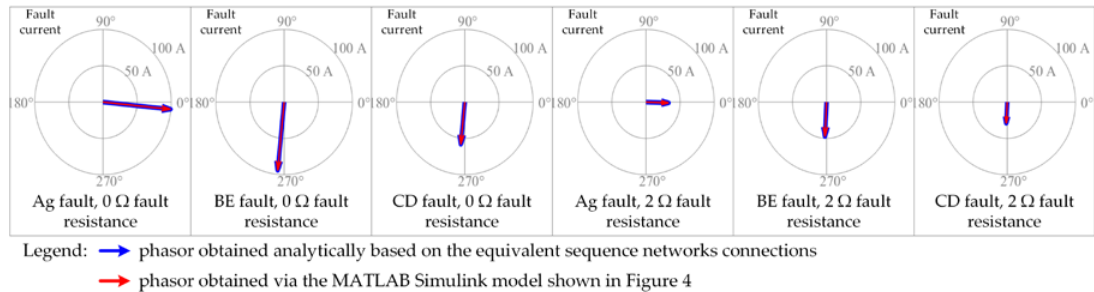
Ω and for R Ω f = 2